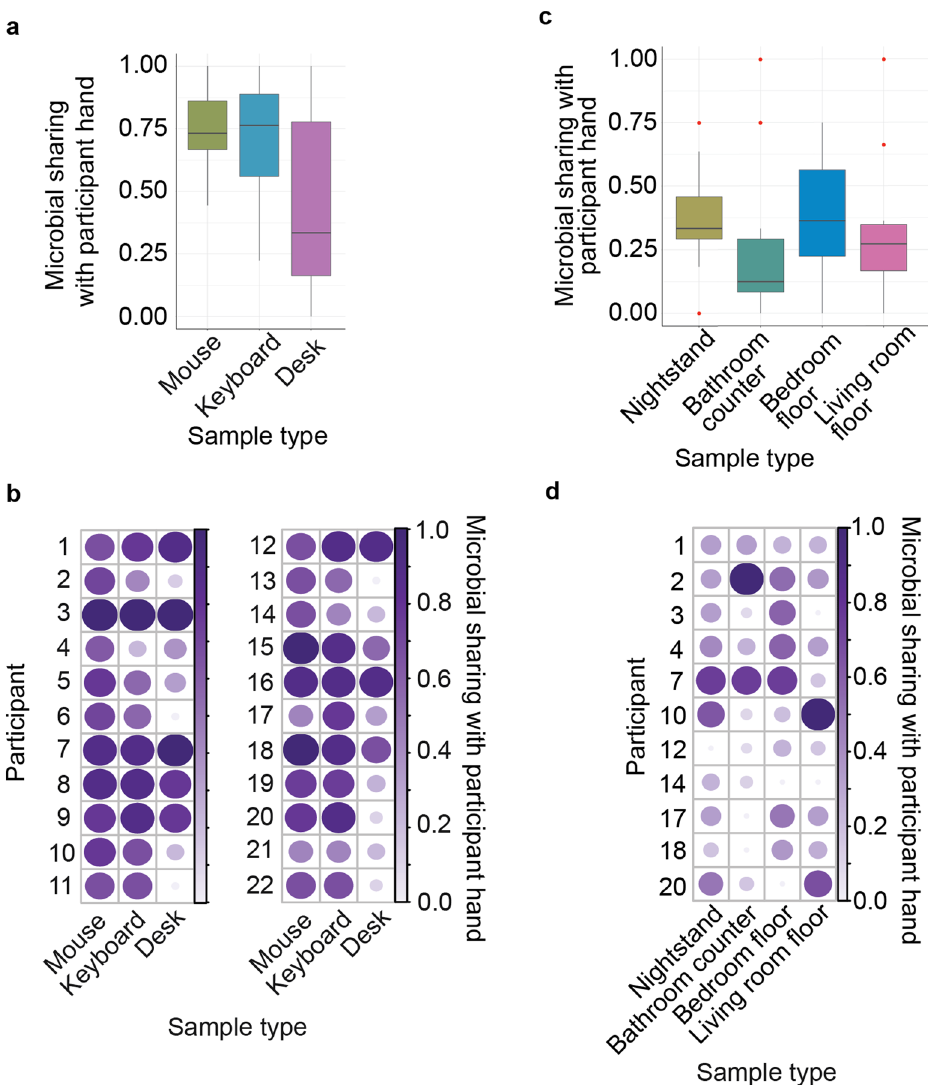
Figure 3. Microbial sharing in the built environment: ( a ) boxplot of microbial sharing with the participant hand by sample type in office. Sample sizes for each sample type were mouse ( n = 65); keyboard ( n = 64); desk ( n = 63); ( b ) circle plot representing the microbial sharing by participant stratified by sample type in office. Lager circles and darker purple represent higher proportions shared communities. Sample sizes for each participant in office can be found in Supplementary Table 3; ( c ) boxplot representing the microbial sharing with the participant hand by sample type in home. Sample sizes for each sample type were nightstand ( n = 31); bathroom ( n = 33); bedroom floor ( n = 31); living room floor ( n = 31); ( d ) circle plot representing microbial sharing by participant stratified by sample type. Larger circles and darker purple represent higher proportions of shared communities. Sample sizes for each participant in home can be found in Supplementary Table 4. Partner hand samples were removed from these figures because not all participants had a